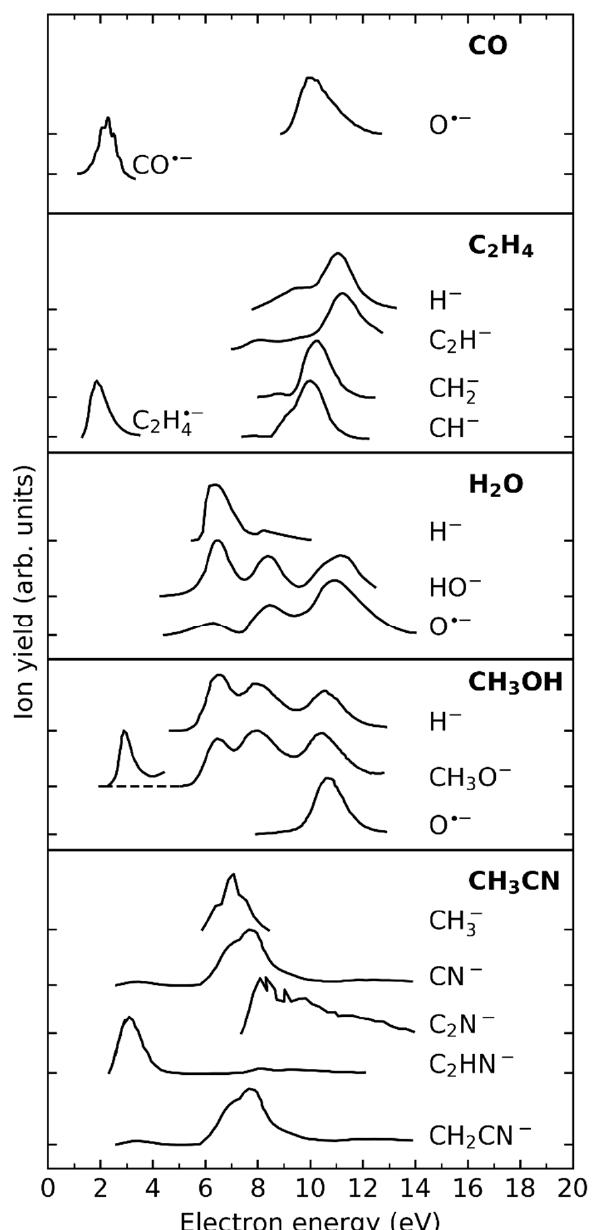
Figure 4. Gas phase EA/DEA channels of molecules for which the electron-induced chemistry in ices is reviewed herein. (D)EA to CO (2 eV to CO from Ref. [55] on charge trapping and 10 eV resonance from Ref. [56] on DEA ion yields), C 2 H 4 (2 eV resonance from Ref. [57] derived from energy-dependent cross section for vibrational excitation and 10 eV resonance from Refs. [58,59] on DEA ion yields), H 2 O (from Ref. [60] on absolute DEA cross sections), CH 3 OH (from Ref. [61] on DEA ion yields) and CH 3 CN (from Ref. [62] on DEA ion yields). Each curve has been normalized to its maximum. The figure does not represent the relative yields of individual fragments from same molecule but merely serves to illustrate the resonance positions. Tick marks on the y-axis indicate the vertical offset. Adapted from Ref. [37] with kind permission of The European Physical Journal